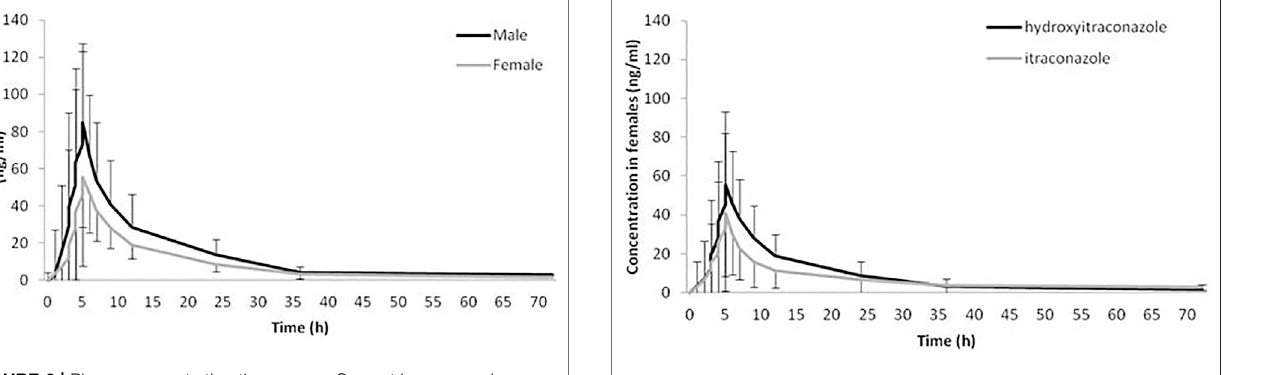
FIGURE 4 | Plasma concentration-time curves of itraconazole and hydroxy-itraconazole after a single oral dose of 100 mg of itraconazole providing 48 sets of plasma concentrations from female healthy Caucasian subjects. Data are presented as geometric mean and standard